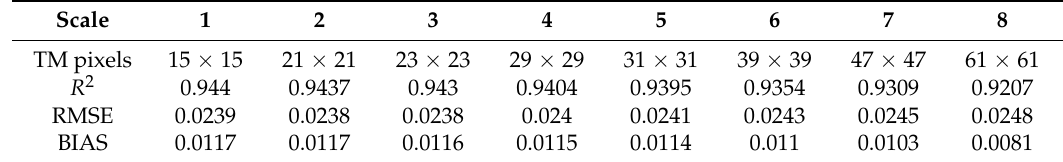
Table 5. Comparative accuracy of MODIS albedo and TM data aggregated with PSF.